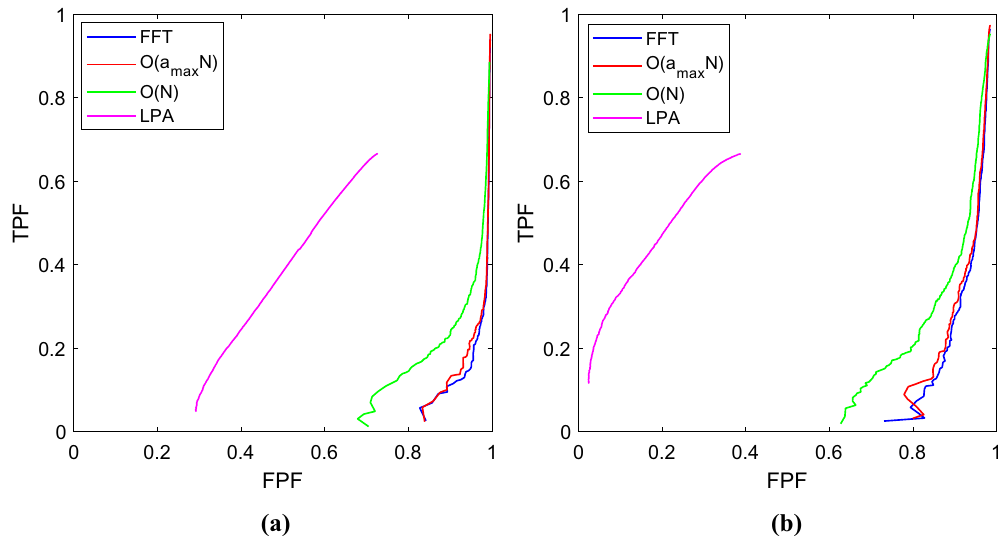
Figure 3. Performance analysis (TPF vs. FPF) of proposed O ( N ) (green), O ( a max N ) (red), and other FFT- based (blue) and LPA (magenta) approaches over real MRI image database of ( a ) MSLS 2008 and ( b ) MSSEG 2016. The O ( N ) method has the highest accuracy among the three NCCC-based approaches. Note that the superior performance of the LPA approach is expected, given that it is supervised segmentation, as opposed to unsupervised template-matching lesion